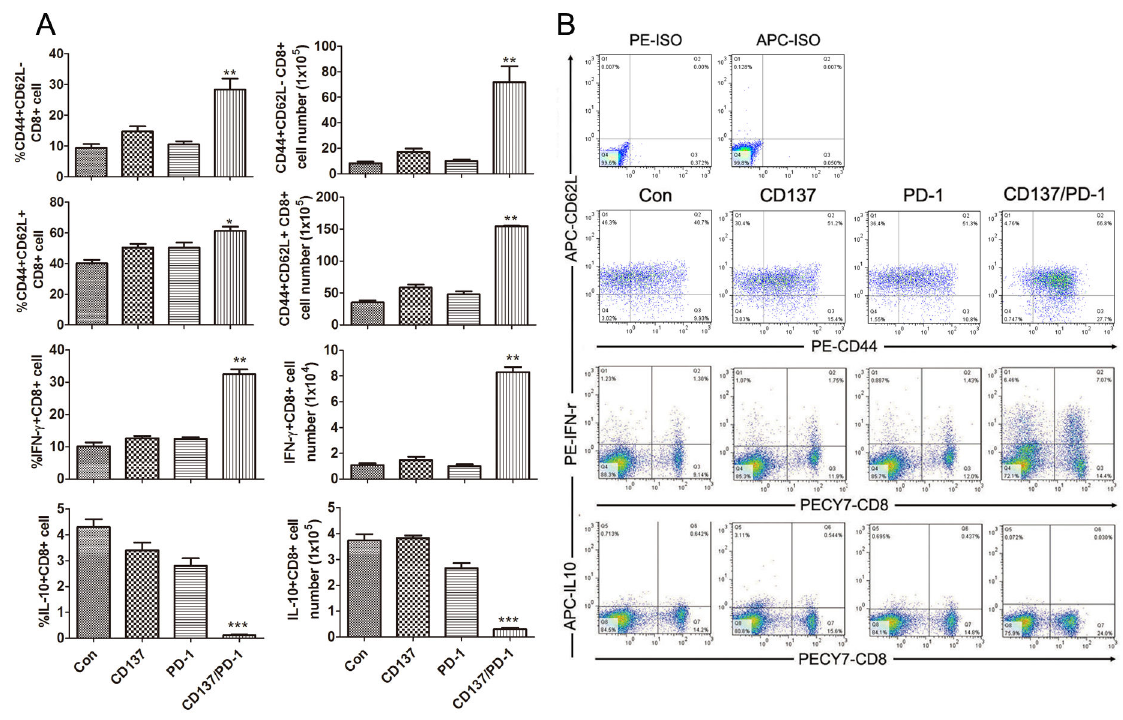
Figure 3. Analysis of effector CD8 + T lymphocyte in spleens from mice treated with mAb combinations. Mice (3/group) which had been transplanted i.p. with 3 × 10 6 ID8 cells 10 days earlier were injected i.p. twice at 4 days interval with 0.5 mg of control, anti-CD137, anti-PD-1 or anti-PD-1/CD137 mAb. Spleens from treated mice were analyzed for phenotypes and effector functions of CD8 + T lymphocytes by flow cytometry 7 days after the second mAb injection. The percentages and numbers of CD44 + CD62L - effector/memory and CD44 + CD62L + central memory and IFN-γ- and IL-10-producing cells in the CD8 + T cell population are shown in (A) and representative dotplots are shown in (B). Data are presented as M±SEM from 3 mice in each group and are representative of 3 independent experiments. *P < 0.05, **P < 0.01, ***P < 0.001, PD-1 or CD137 mAb compared with control mAb, PD-1/CD137 mAb compared with control and single